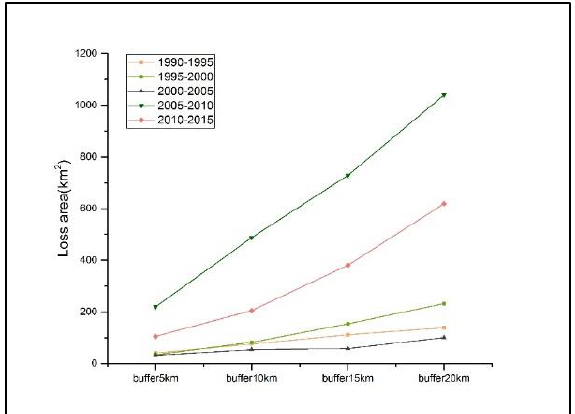
Figure 5. Forest loss in different buffers